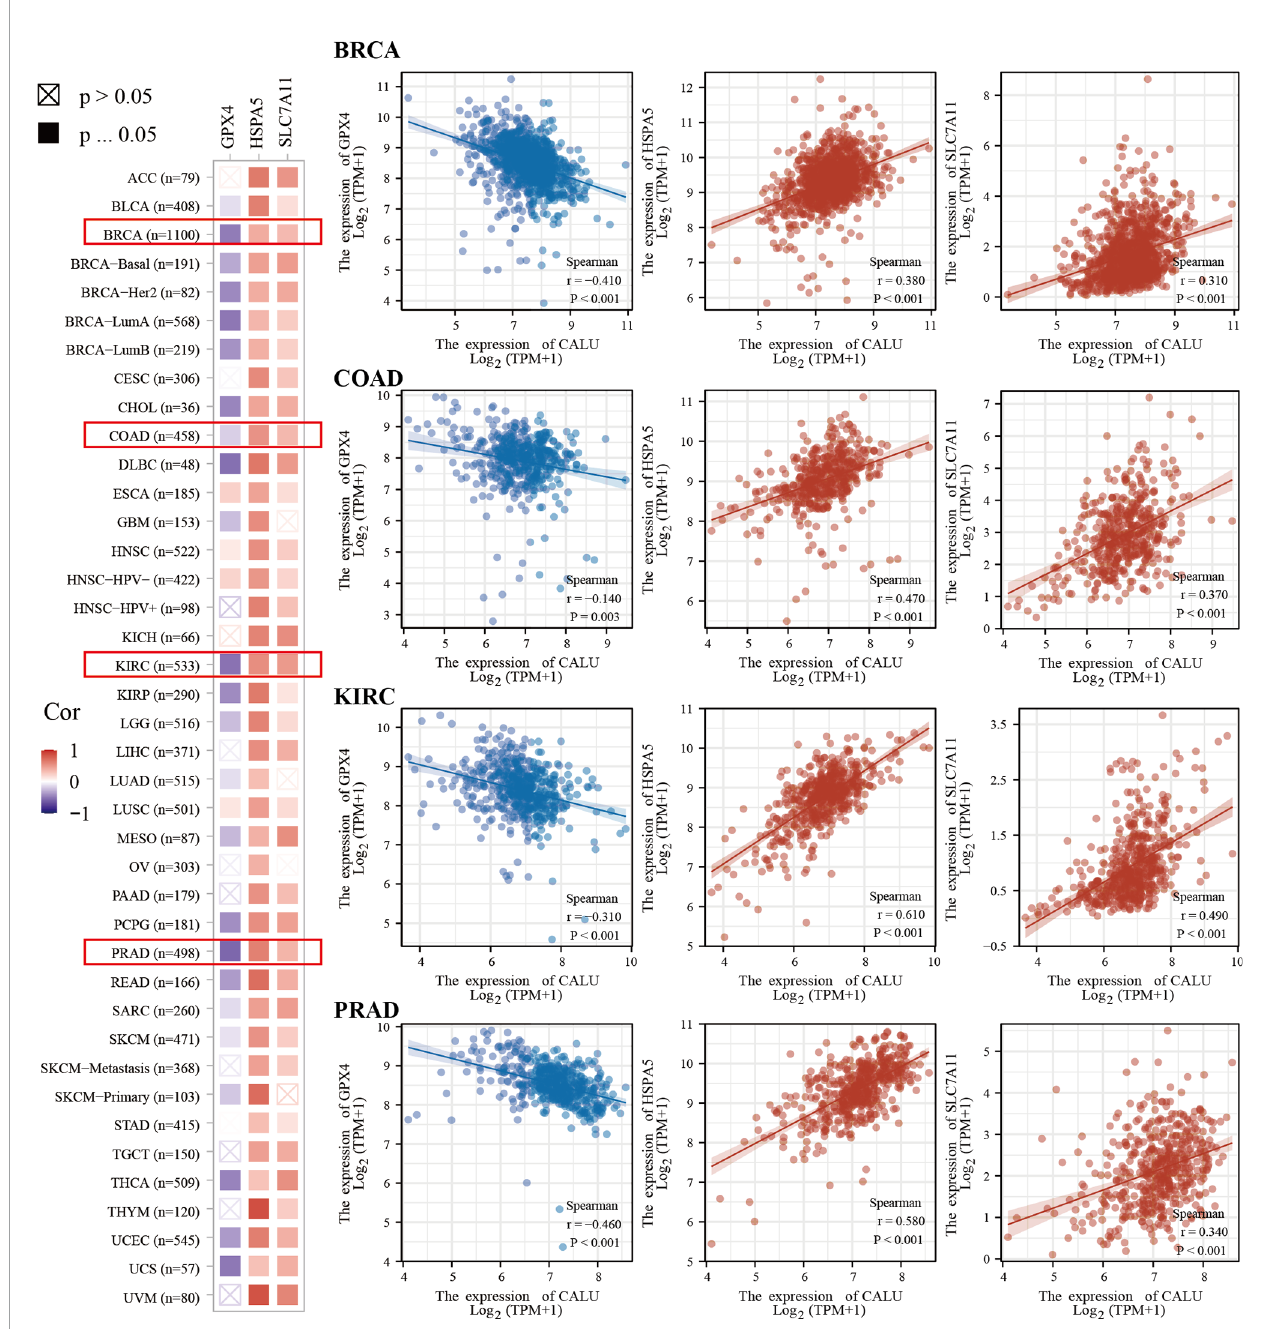
FIGURE 8 | Pan-cancer analysis of the correlation of CALU with GPX4, HSPA5 and SLC7A11. CALU was signi fi cantly associated with HSPA5, SLC7A11 and GPX4 in tumors where ferroptosis was commonly observed, including breast, kidney, colon and prostate